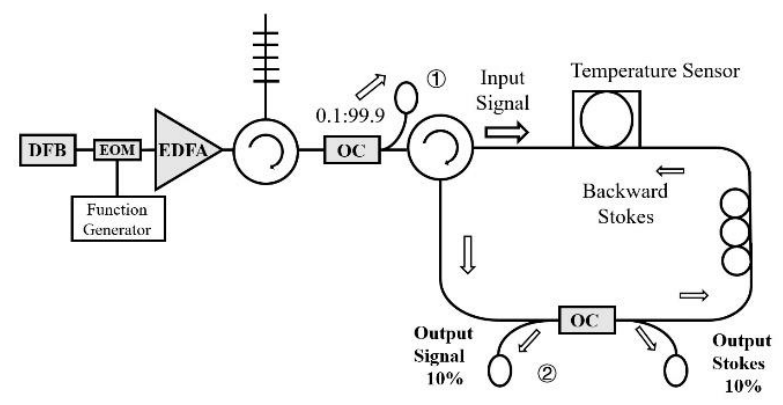
Figure 1. The proposed experimental setup. DFB: distributed feedback laser; EDFA: erbium-doped fiber amplifier; OC: optical coupler.